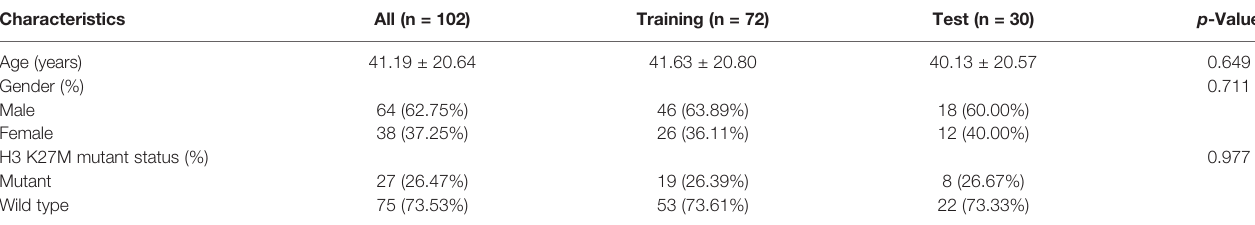
TABLE 1 | Baseline characteristics of the training and test groups. Characteristics